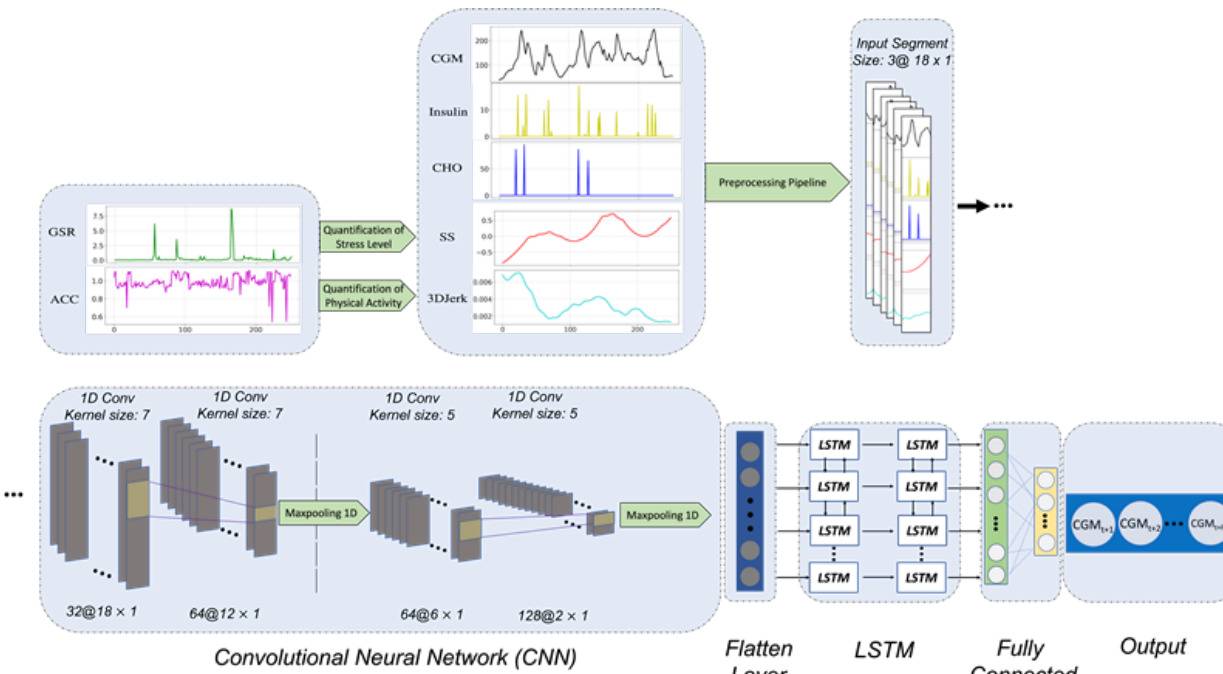
Figure 2. The architecture of the proposed CNN-LSTM model. Raw ACC and EDA signals are used to estimate PAI and SSI features, respectively. Then, these generated features, along with the CGM, insulin, and CHO signals are passed through the preprocessing pipeline.